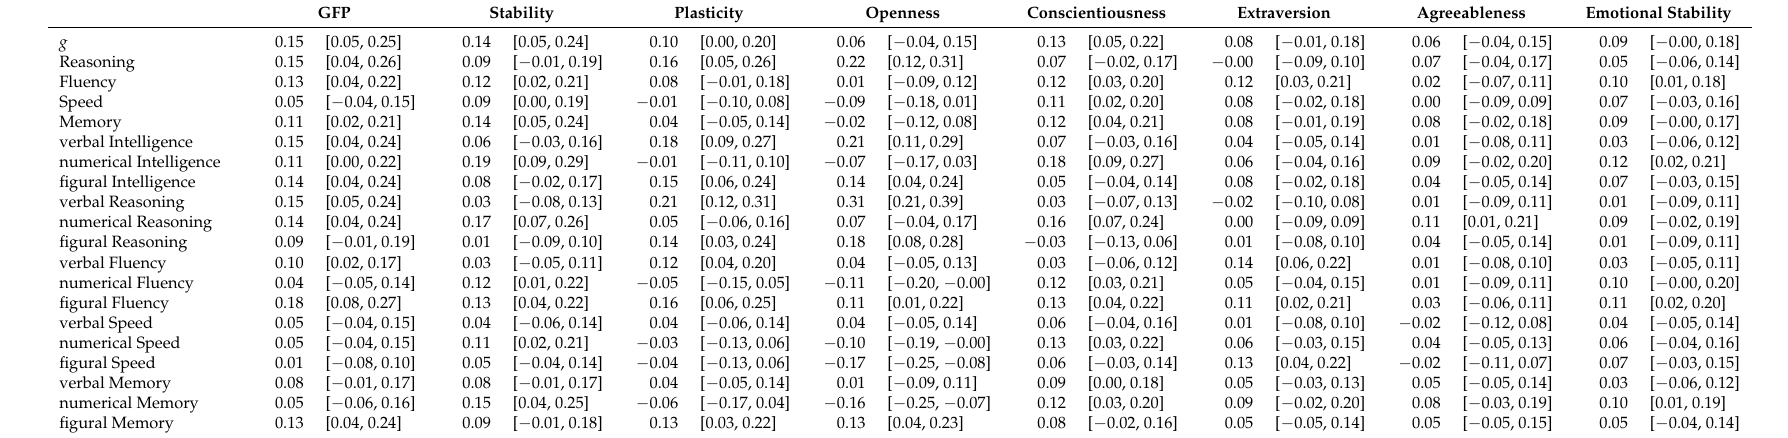
Table 4. Study 2: Bootstrapped correlations (controlled for gender) between personality and intelligence. 95% CI in brackets. GFP Stability Plasticity Openness Conscientiousness Extraversion Agreeableness Emotional